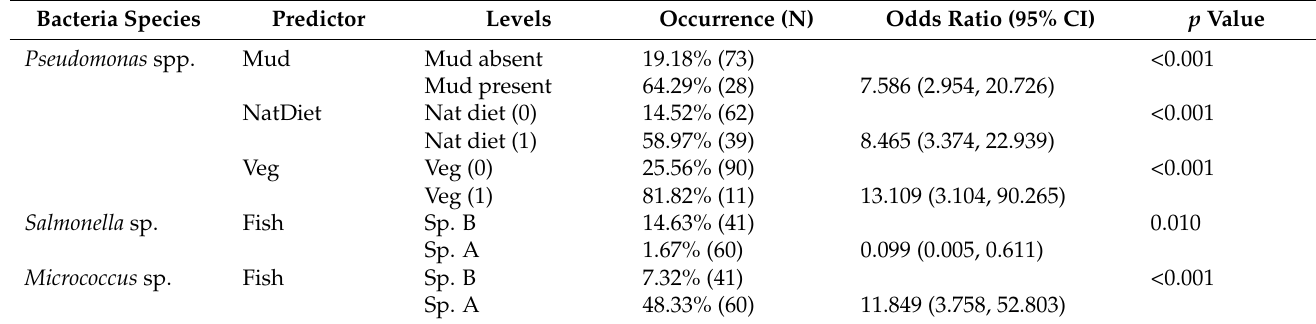
Table 6. Associations between predictor variables and bacteria. Odds ratios calculated using the first level as a reference. Bracketed numbers in ‘Occurrence’ column show the total